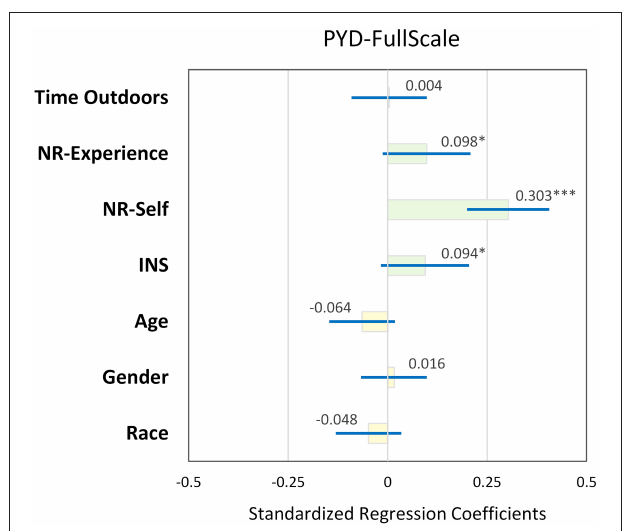
FIGURE 2 | Standardized coefficients ( β , with 95% CI) in OLS regression model examining association between time in nature (Time Outdoors), connection to nature [Nature-relatedness: Experience, Nature-relatedness: Self, Inclusion of Nature in Self (INS) Scale], and overall positive youth development (PYD) scale scores in a sample of rural middle school students in South Carolina, USA, controlling for demographic variables ( n = 587). * , ** , and *** indicate significance of standardized β at α = 0.10, 0.05, and 0.01, respectively.